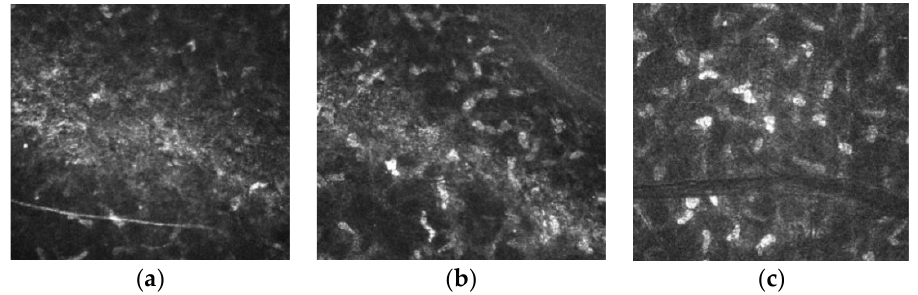
Figure 8. Confocal laser microscopy imaging in the interface area ( a ) three days postoperatively, ( b )